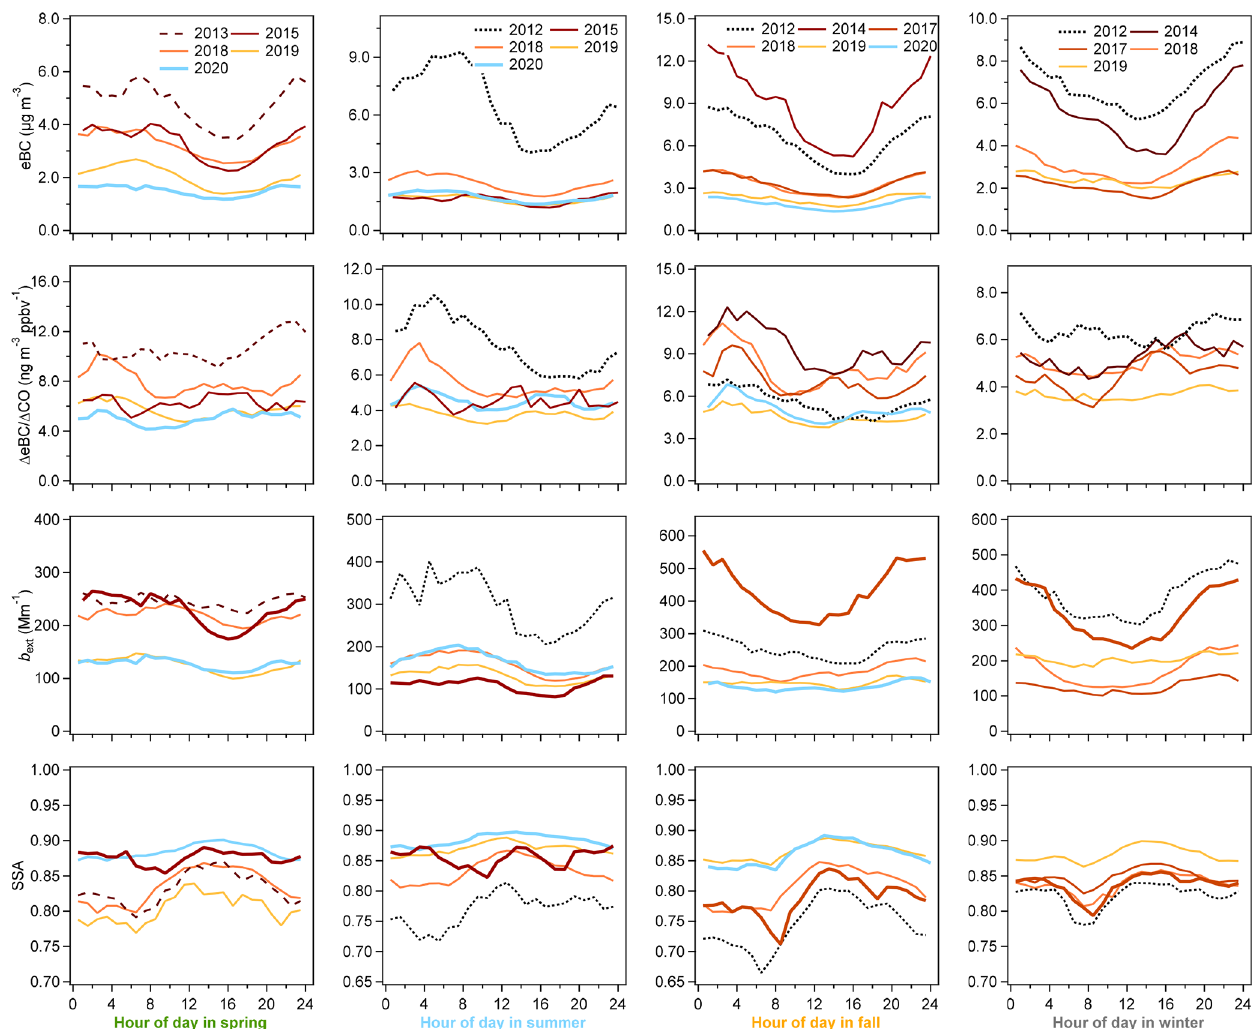
Figure 4. Diurnal variations of eBC, (cid:49) eBC /(cid:49) CO, b ext , and SSA for spring, summer, fall, and winter in different years.